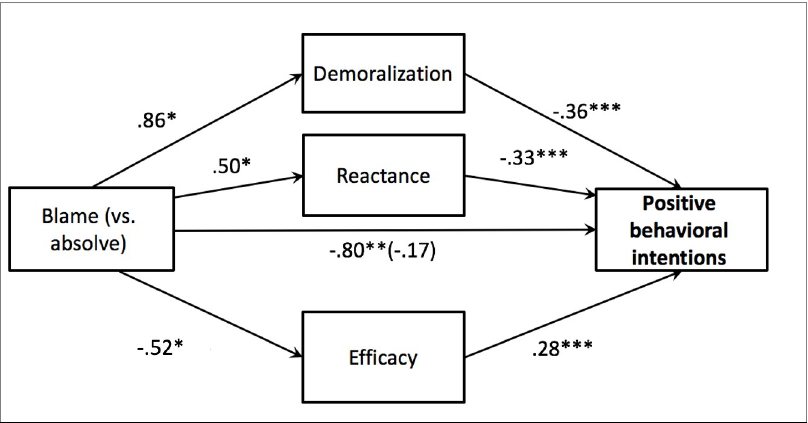
Fig 4. Model testing the effect of condition (blaming vs. absolving) on positive behavioral intentions towards veg � nism through demoralization, reactance, and efficacy beliefs for Study 3. Note . Unstandardized coefficients displayed. � p < .05, �� p < .01, ��� , p < .001, one-tailed